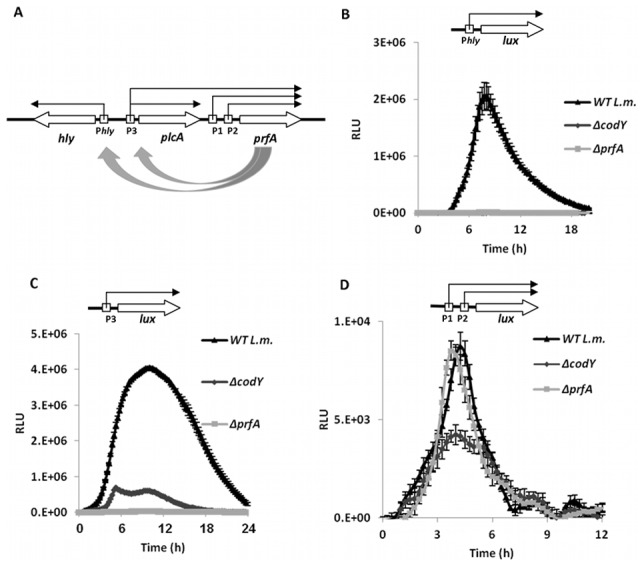
CodY is involved in a positive regulation of prfA transcription.A. Schematic representation of hly, plcA and prfA gene organization and respective promoter regions. B. Luminescence measurements of ΔcodY, ΔprfA and WT L. monocytogenes bacteria harboring a pPL2-Phlylux plasmid indicating Phly promotor activity during growth in MDM with low BCAA concentrations. C. Luminescence measurements of ΔcodY, ΔprfA and WT L. monocytogenes bacteria harboring pPL2-P3plcA/prfAlux plasmid indicating P3plcA/prfA promoter activity during growth in MDM with low BCAAs concentrations D. Luminescence measurements of ΔcodY, ΔprfA and WT L. monocytogenes bacteria harboring pPL2-P1P2prfAlux plasmid indicating P1P2prfA promoter activity during growth in MDM with low BCAAs concentrations. Overnight precultures were grown in MDM. The data represent 3 independent experiments (N = 3). Error bars indicate a standard error of the mean.